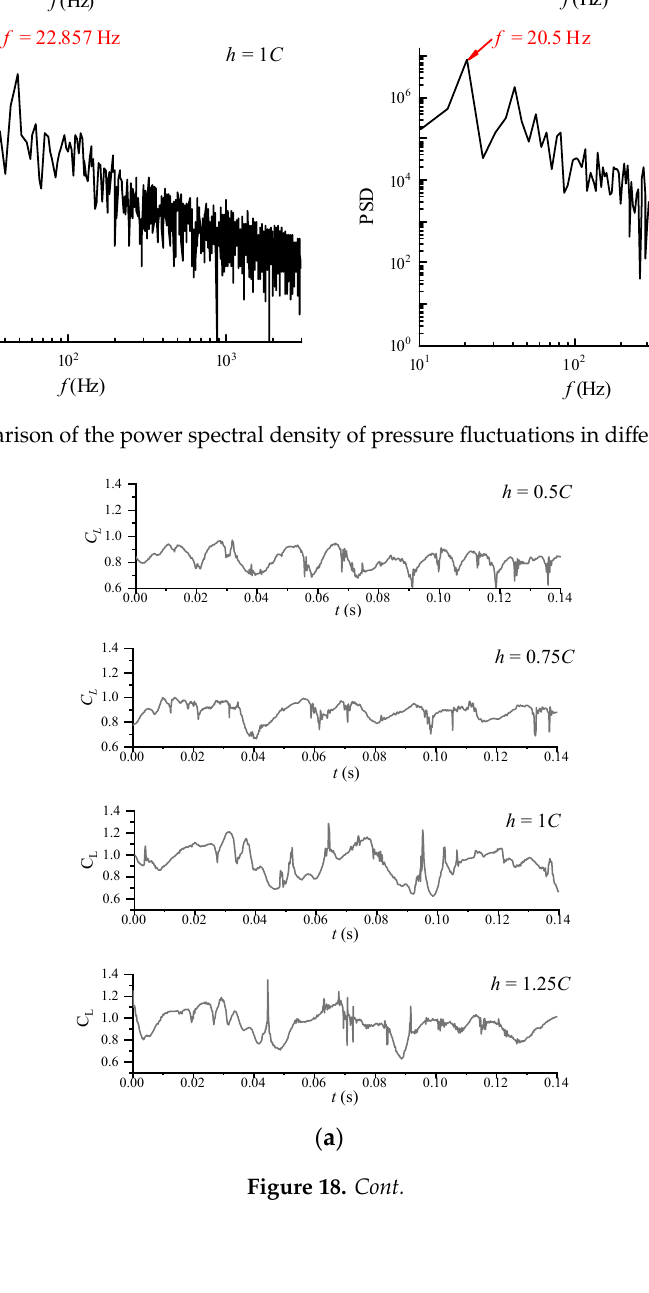
Figure 17. Comparison of the power spectral density of pressure fluctuations in different water depths.